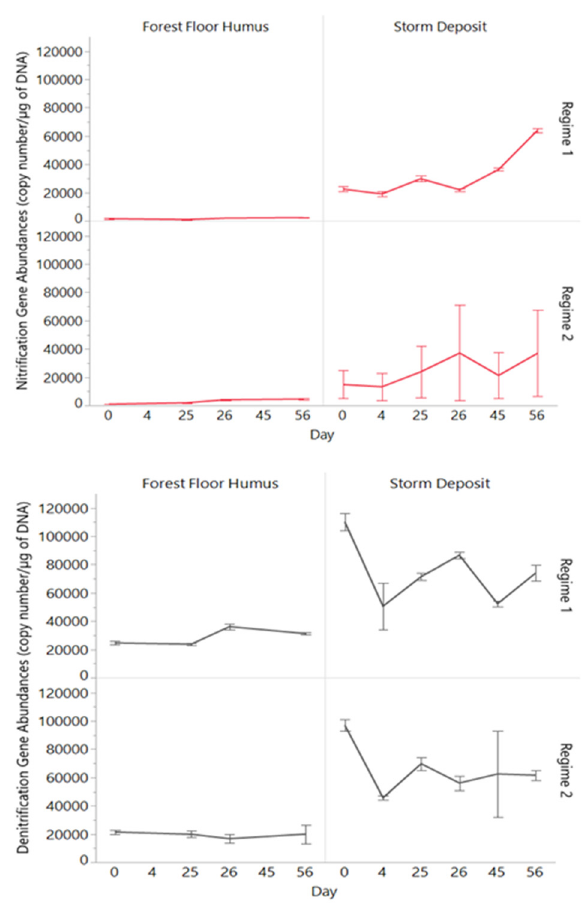
Figure 10. Temporal changes in nitrification (red) and denitrification (black) gene abundances (copy number/ μ g of DNA) over the incubation period for the five sources and two moisture regimes. Nitrification and denitrification gene abundance measurements were taken on day 0, 4, 25, 26, 45, and 56 and their means are reported as points on the graph. Standard deviation is denoted with error bars.